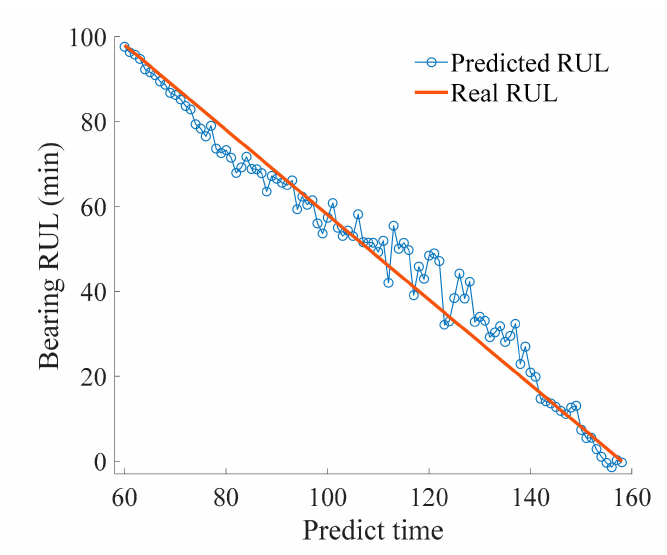
Figure 8. Comparison of predicted RUL and real